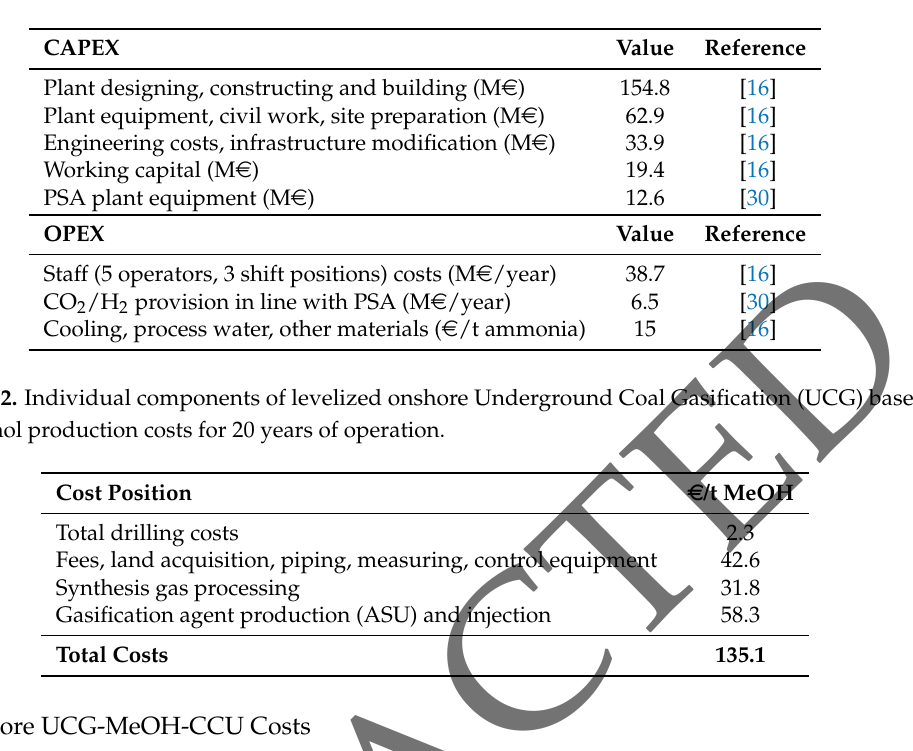
Table 11. Costs positions for methanol production process stages combined as Underground Coal Gasification (UCG) based methanol production costs.